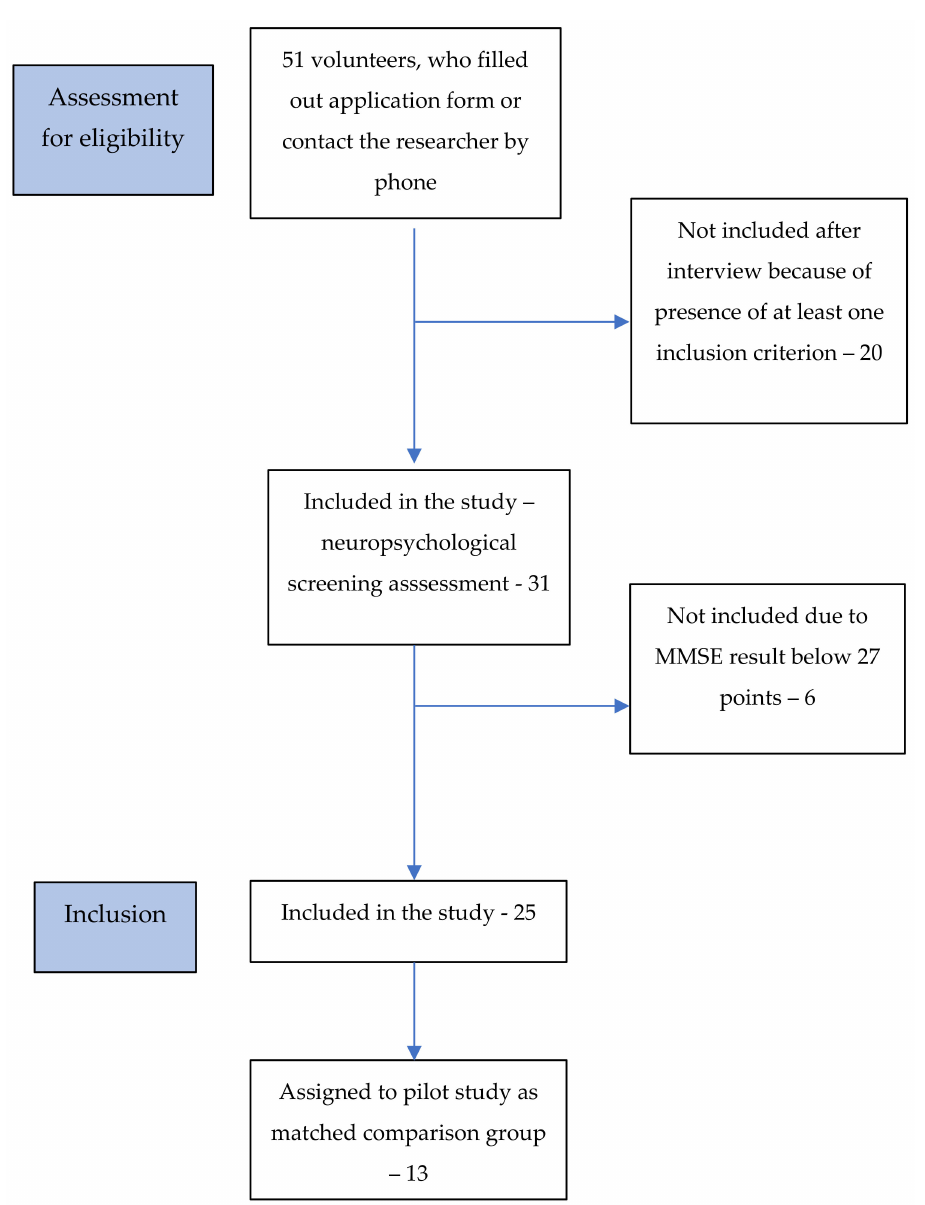
Figure 2. Flowchart showing the progression of the comparison group through the recruitment and study